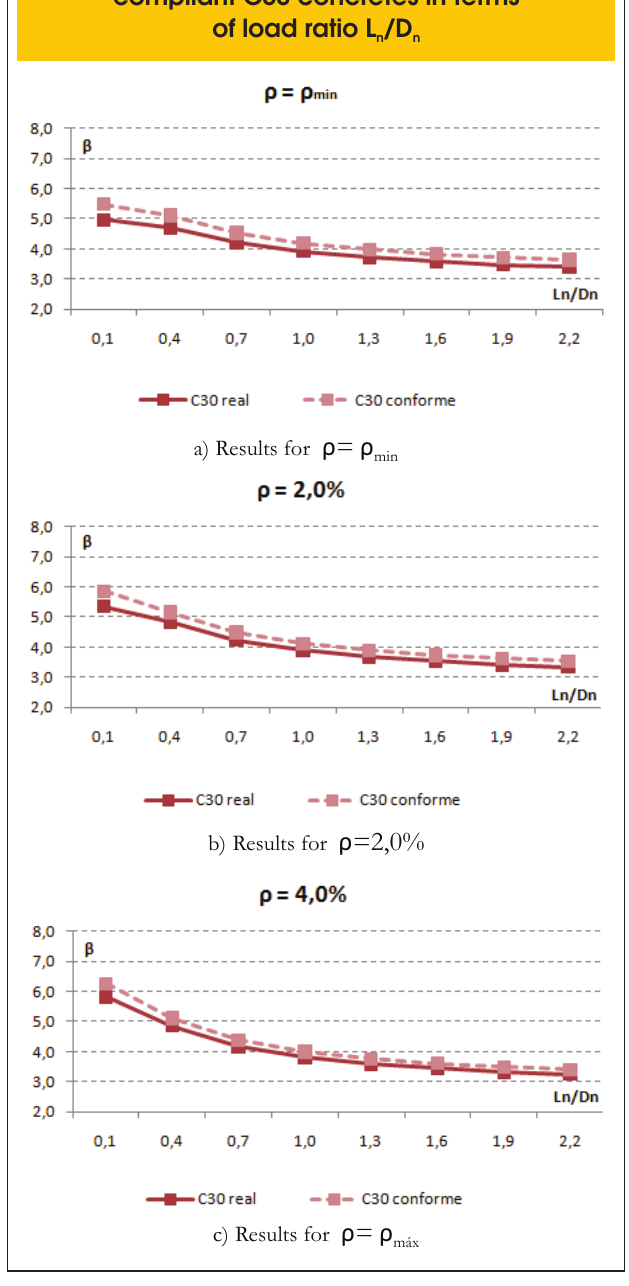
Figura 6 – Reliability index results for real and compliant C30 concretes in